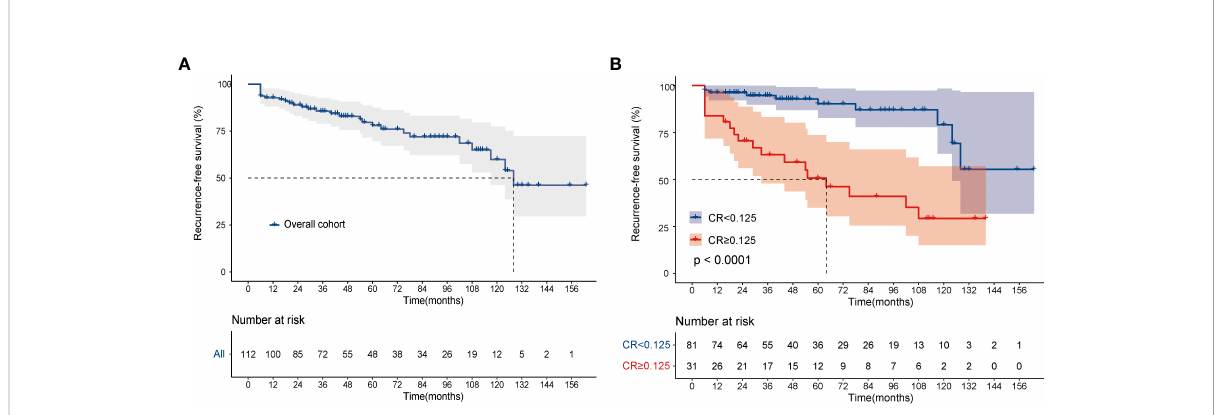
FIGURE 3 Kaplan-Meier curves for recurrence-free survival. (A) overall cohort; (B) according to CR. The log-rank test was used to compare curves. CR, postoperative calcitonin-to-preoperative calcitonin